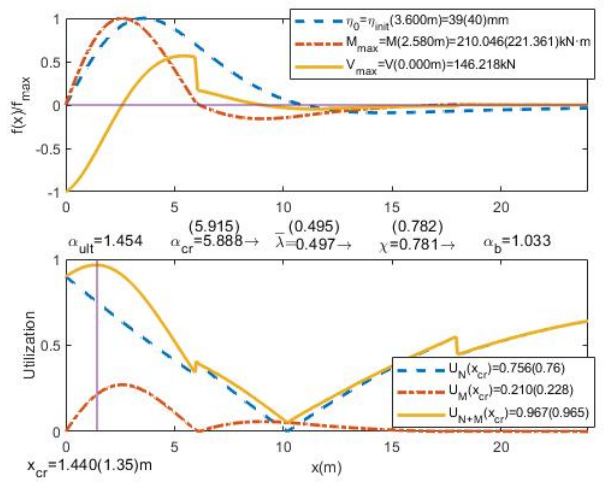
Figure 3. Example 1: UGLI imperfection η init , bending moment M , shear force V , utilization factor U . Values in brackets are from [7].